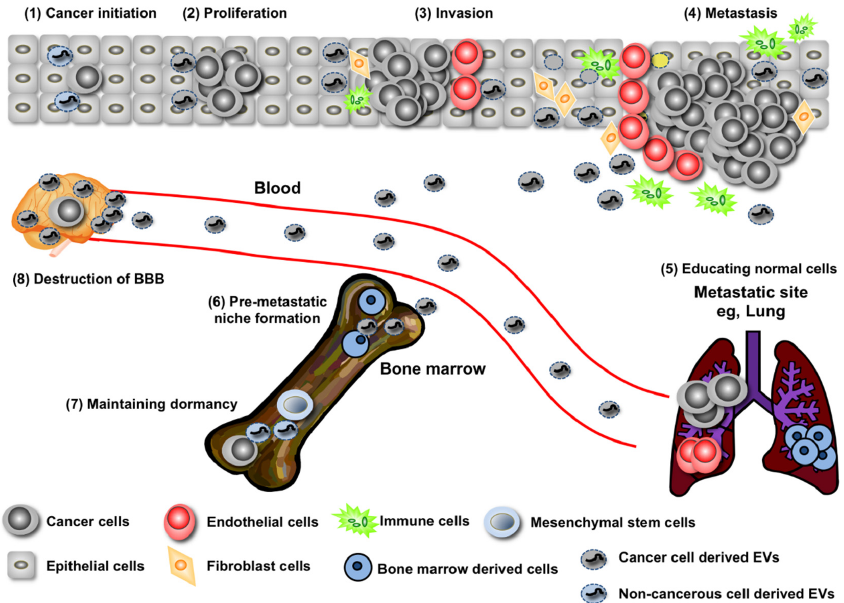
Figure 1. EVs from cancer cells manipulate the cells in their microenvironment. EVs are involved in every step of cancer development. In cancer’s initiation stage, normal cells prevent the outgrowth of cancer cells by secreting tumor suppressive miRNAs through EVs (1); however, the cancer cells can avoid this inhibitory machinery, finally resulting in a tumor expansion (2). Cancer cells exhibit genes to cancer cells that do not harbor those genes (2); Many reports have shown that cancer cell ‐ derived EVs promote cancer malignancy (3,4). In addition, cancer cell ‐ derived EVs